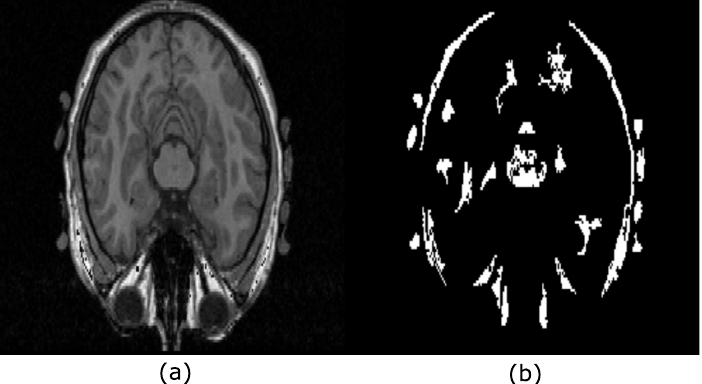
Figure 4. Hyperconnectivity concept. ( a ) The image shows a hyperconnection because all the structures into the head overlap, forming a unique component; ( b ) regional maxima detected from the image in ( a ) after applying the filter ˜ γ µ = 2 ˜ ϕ µ = 2 ( f ) .